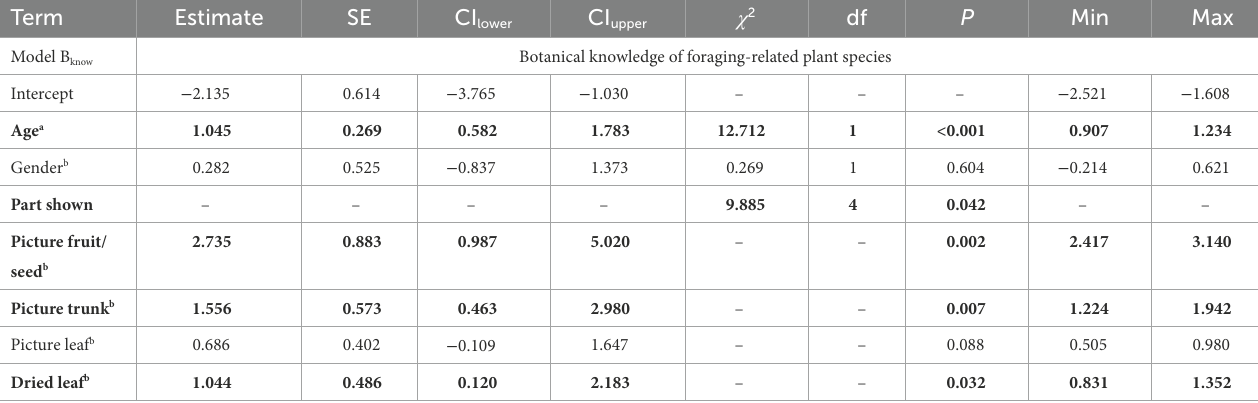
TABLE 3 Botanical knowledge of foraging-related plant species.